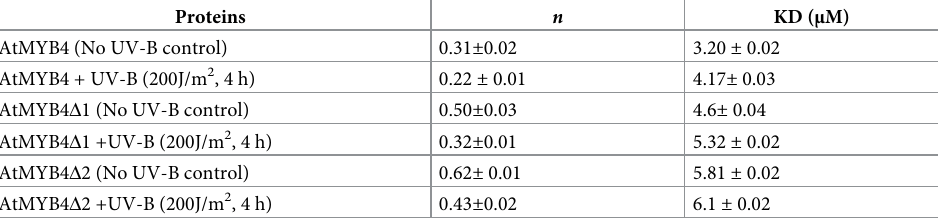
Table 1. Determination of stoichiometry ( n ) and dissociation constant (KD) of untreated control and UV-B irra- diated recombinant AtMYB4 and the N terminus deletion